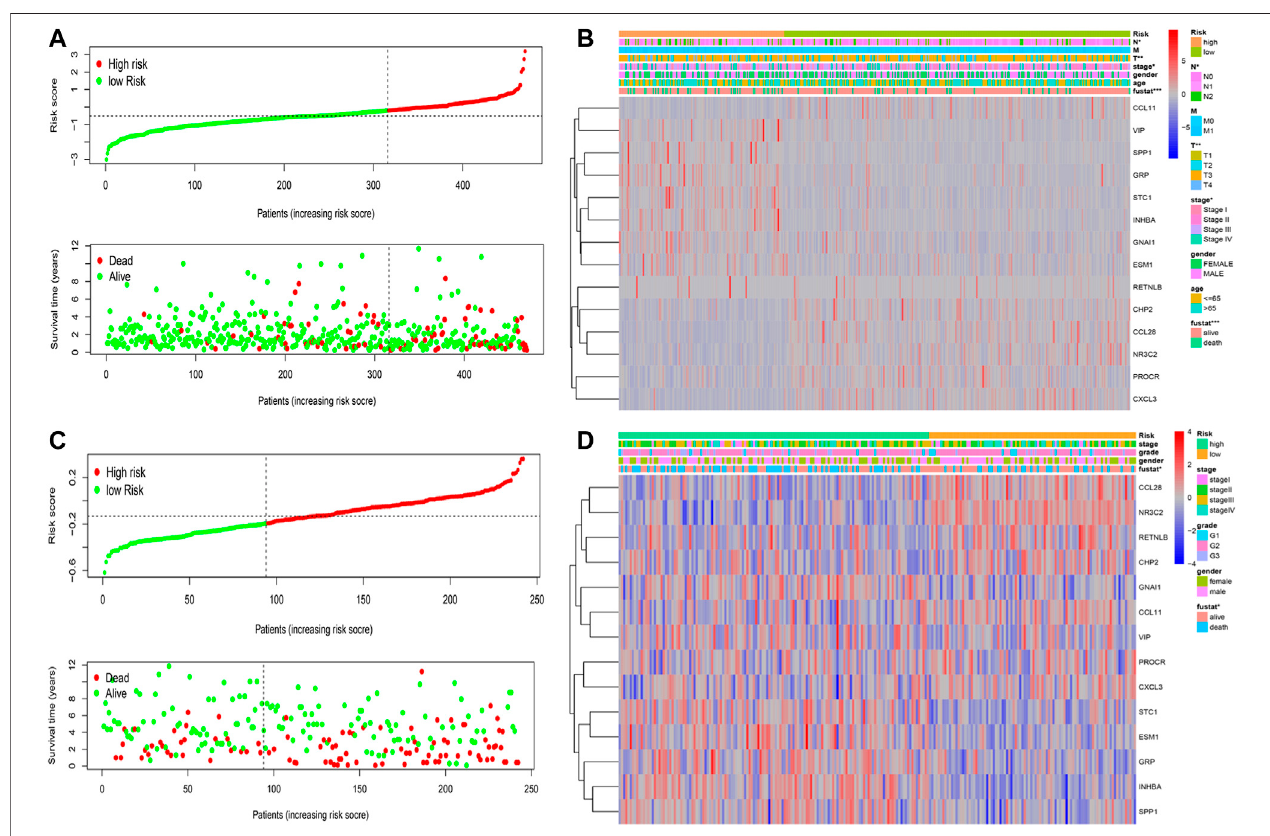
FIGURE 4 | Risk IRG landscapes. (A – C) Risk score distribution, survival status, and duration of CRC patients in the training and test cohorts (B – D) Risk score analysis of the 14 IRGs prognostic model and clinical characteristics demonstrated by a heatmap for the training and test cohorts.